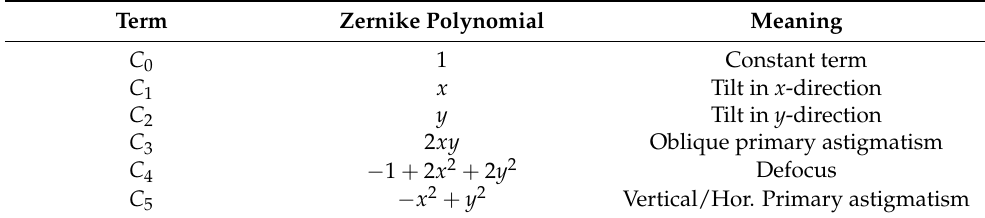
Table 1. Zernike coefficients in Cartesian coordinates, C 0 − C 5 . Term Zernike Polynomial